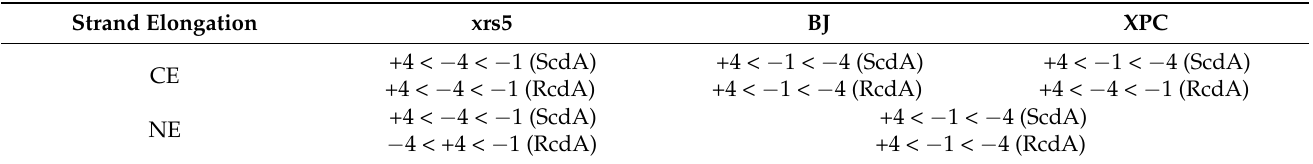
Figure 5. The polymerase activity (observed after 30 min of reaction time) for oligonucleotides containing ds-CDL (shown in Figure 2 and Table S1) treated with cytoplasmic extracts (CE) obtained from three cell lines—xrs5, BJ, and XPC (raw numerical data is presented in Supplementary Materials in Tables S6–S11) and with nuclear extracts (NE) obtained from the same cell lines in previous studies [8,30]. Table 3. The general trends of polymerase activity observed after 30 min of reaction time for oligonucleotides containing ds-CDL (shown in Figure 2 and Table S1) treated with cytoplasmic extracts (CE) obtained from three cell lines (raw numerical data is presented in Supplementary Materials in Tables S6 – S11) and with nuclear extracts (NE) obtained from three cell lines in previous studies [8,32]. Frames indicate substrates with elongation efficiency higher than for corresponding Control 1 (Table 1 and [8,30]).